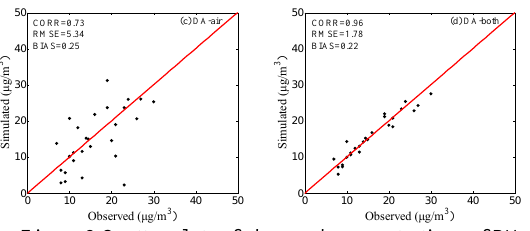
Figure 3 Scatter plots of observed concentrations of PM 2.5 versus simulated concentrations of PM 2.5 from the experiments of Control (a), DA-sfc (b), DA-air (c) and DA-both (d) surface over 02:00 PDT initializations.